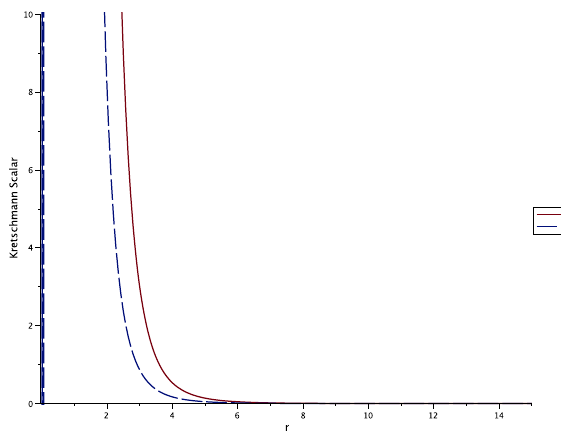
Fig. 6 PlotoftheKretschmannscalar,forEAparameters c 14 = 48 / 25, | γ | = 1 and an arbitrary Schwarzschild mass M = 27 / 2. The continu- ous red line represents the GR Schwarzschild metric. The dashed blue line represents the EA solution. Calculating the limit r → +∞ we obtain K → 0. Calculating the limit from left r → r sing 1 = 0 we obtain K → −∞ , as we can see in this figure. Calculating the limit from right r → r sing 1 = 0 we obtain K → +∞ , as we can see in